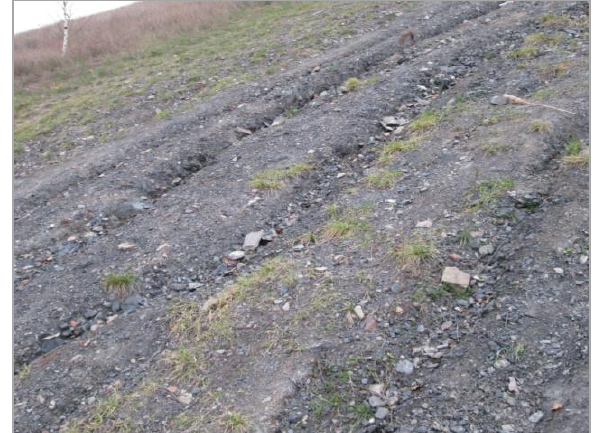
Fig. 8. Vegetation covering the spoil tip of mine “Murcki-Staszic” in Katowice Kostuchna ( J. Pełka-Gościniak, November 2014